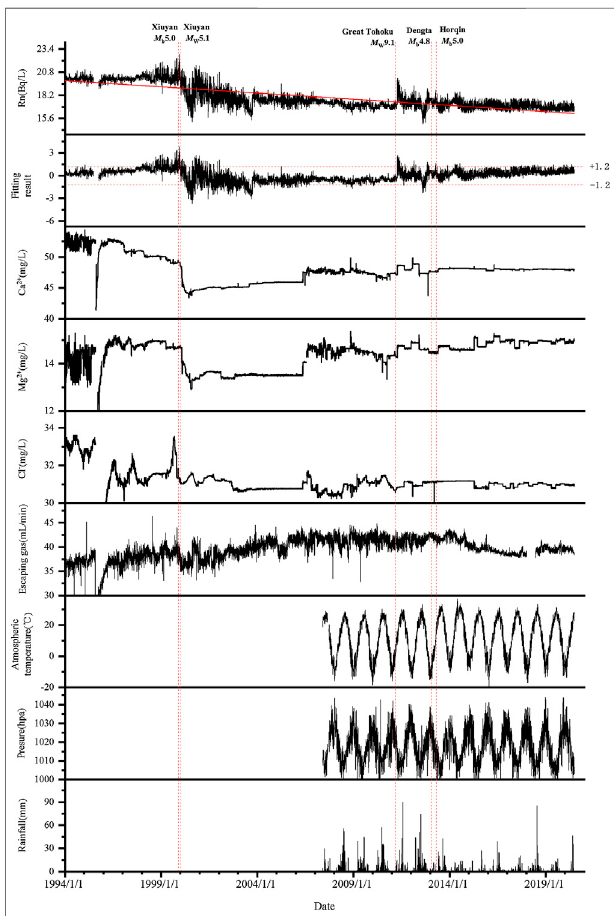
FIGURE3| Timeseriesofwaterradonconcentration, fi ttingresult,Ca 2+ , Mg 2+ , and Cl − concentrations, escaping gas fl ow, atmospheric temperature, pressure, and rainfall of the Panjin observation well for the period 1994 – 2020. The dates of earthquakes are marked by vertical red dashed lines. The red trend line is the linear fi tting of the observed water radon concentration. The fi ttingresultiscalculatedusingthesubtractionmethodbetweenobserved water radon concentration and the linear fi tting; mean square error (MSE) is ± 1.2.